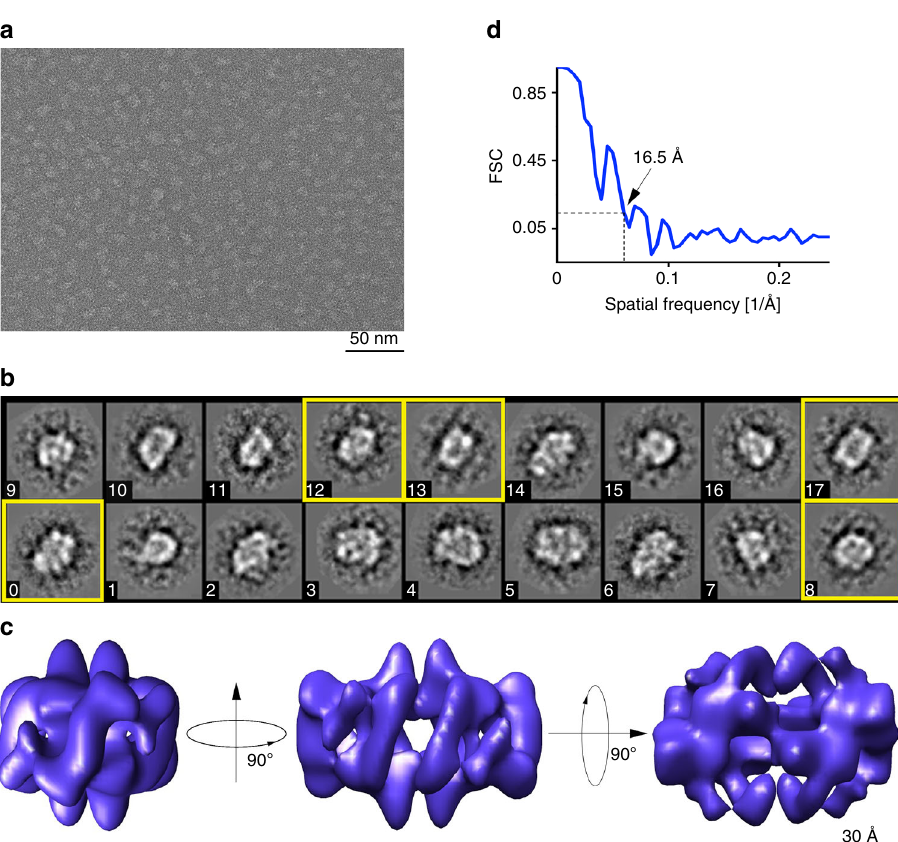
Fig. 2 Electron microscopy analyses of Bri2 BRICHOS oligomers. a Transmission electron micrograph of negatively stained Bri2 BRICHOS oligomers recorded with a JEOL JEM2100F electron microscope and a DE-20 direct electron detector. b Representative 2D-classes of Bri2 oligomers. The class averages are consistent with an approximate 2-fold symmetry. The yellow frames indicate the most obvious 2-fold views. The side of each box side is approximately 22 nm. c 3D density map of Bri2 BRICHOS oligomer with dihedral (D2) symmetry. The viewing directions are parallel to the three different 2-fold axes. The map was based on 2718 particles extracted from images recorded on a DE-20 detector. The voxel size of the map is 2.076 Å. d The Fourier shell correlation (FSC) curve between reconstructions was produced by splitting the data set in two halves. Both halves were reconstructed separately. The resolution of ~17 Å for the reconstructed 3D density map was calculated from the curve at FSC = 0.143 (dotted